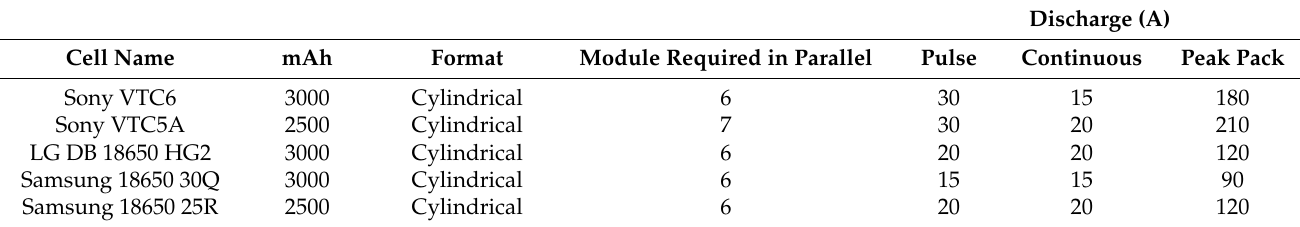
Table 4. Selection of the five best-fitting Li-ion cells